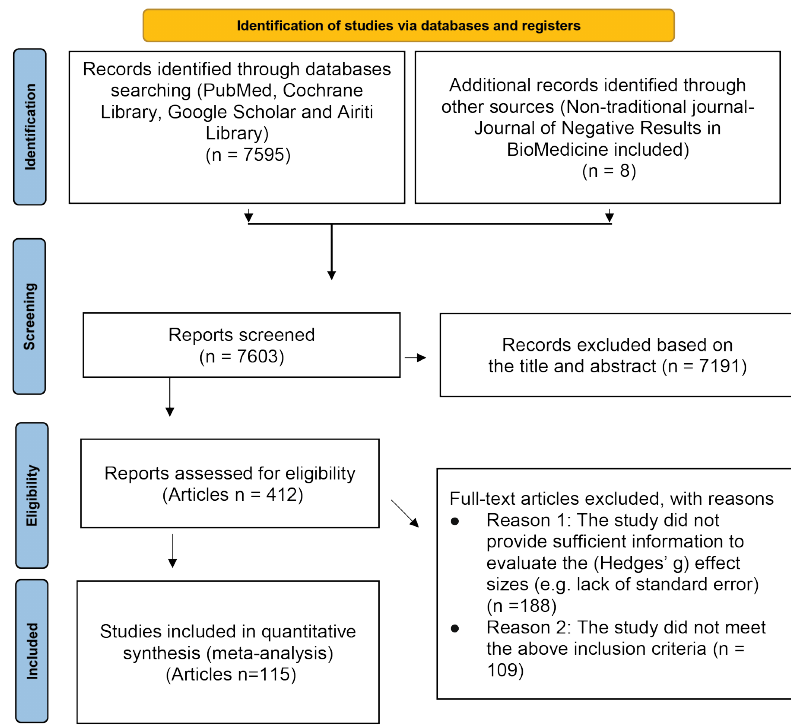
Figure 1. PRISMA flow